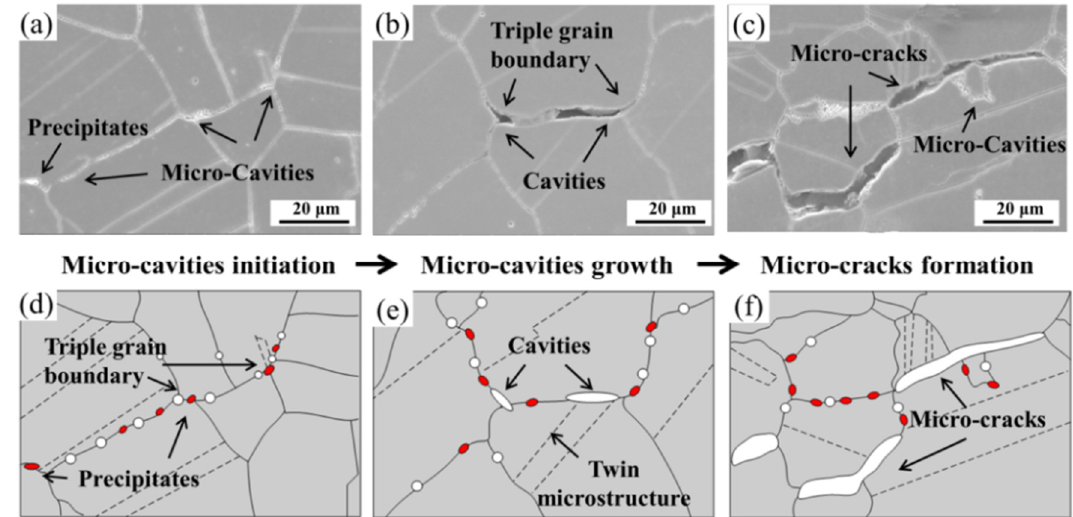
Figure 15. Schematic of the creep rupture behavior: ( a , d ) micro-cavities nucleation around the triple grain boundary and precipitates; ( b , e ) micro-cavities growth and coalescence; ( c , f ) micro-cavities form cracks.